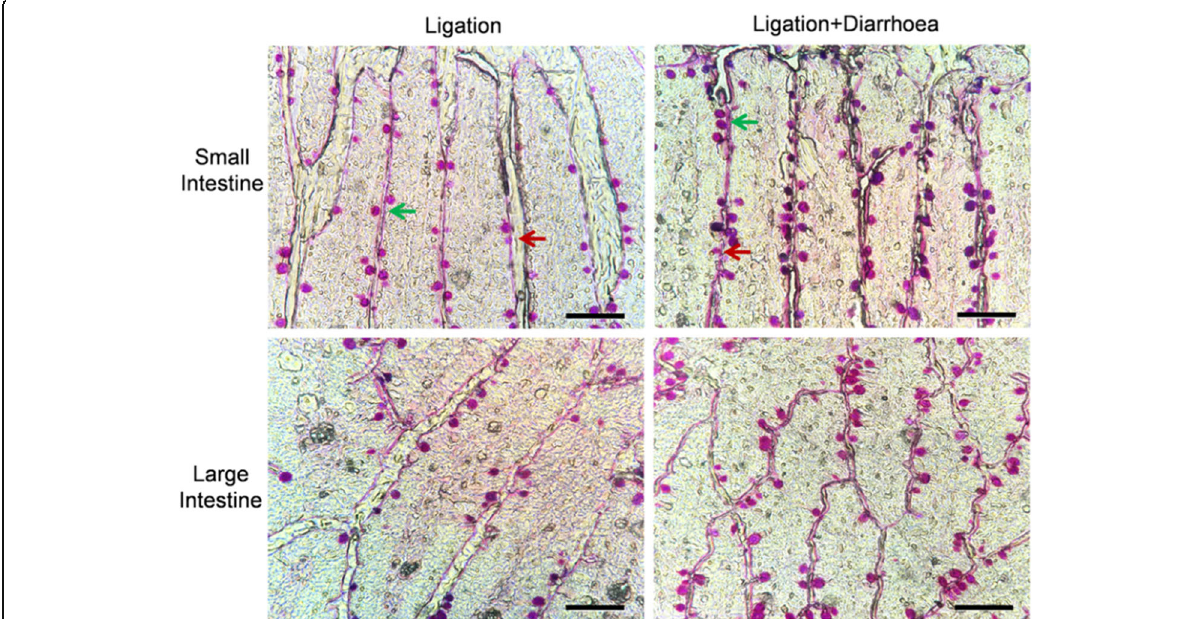
Fig. 6 Photomicrographs of intestinal tissue stained with Alcian Blue/Schiff ’ s reagent to visualize goblet cells. Images are representative of mice treated with saline (Ligation groups) and senna leaf (ligation + diarrhea groups) with arrows indicating non-cavitated goblet cell (green arrow) and cavitated goblet cell (red arrow) secreting mucin. All bars are 100 μ m